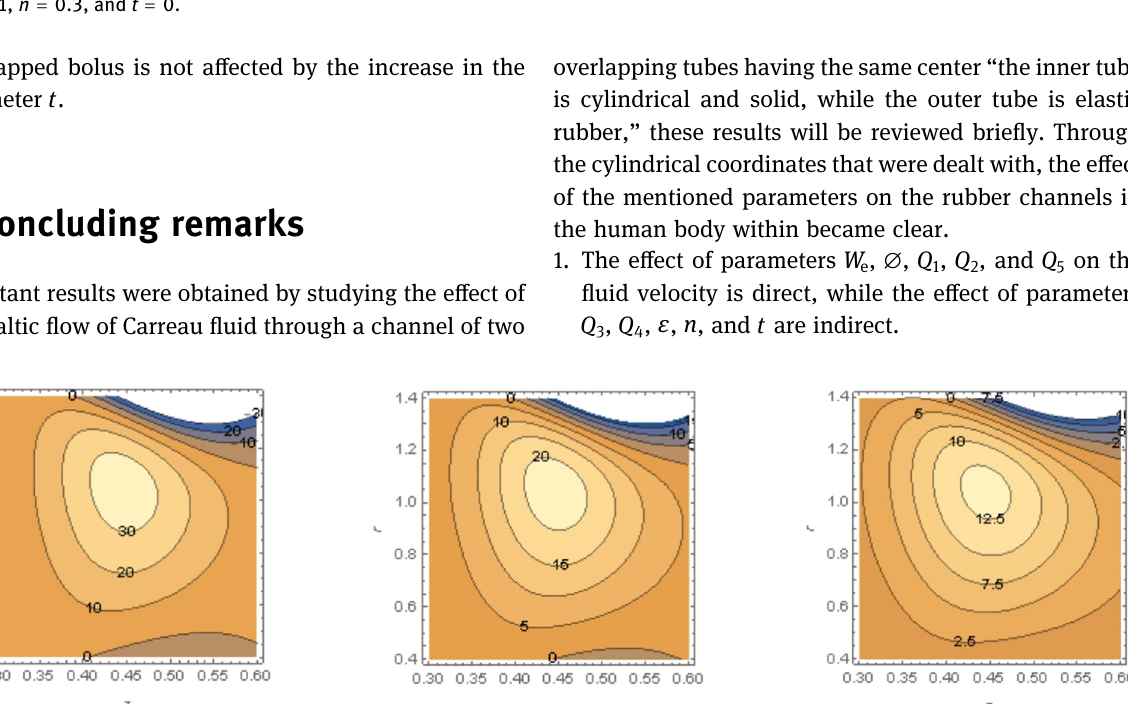
Figure 24: Various values of the wave frame streamlines of Q 4 = { 0.4, 1.4, 2.4 } at W